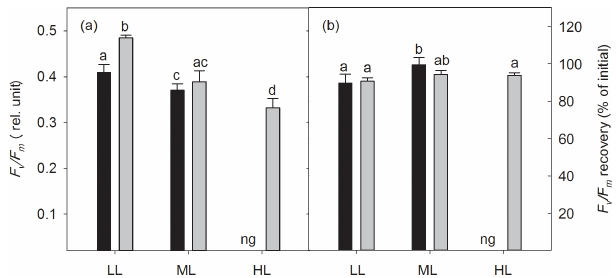
Figure 2. The dark-adapted maximum PSII quantum yield F v /F m (a) and the yield recovery after short-term light stress (% of initial F v /F m ) (b) for Geminigera cryophila acclimated to ambi- ent (black bars) or high CO 2 (gray bars) conditions combined with low (LL), medium (ML) or high light (HL). G. cryophila did not grow under ambient p CO 2 and HL as indicated by ng. Values rep- resent the means ± SD ( n = 3). Different letters indicate significant differences between treatments ( p < 0 . 05).